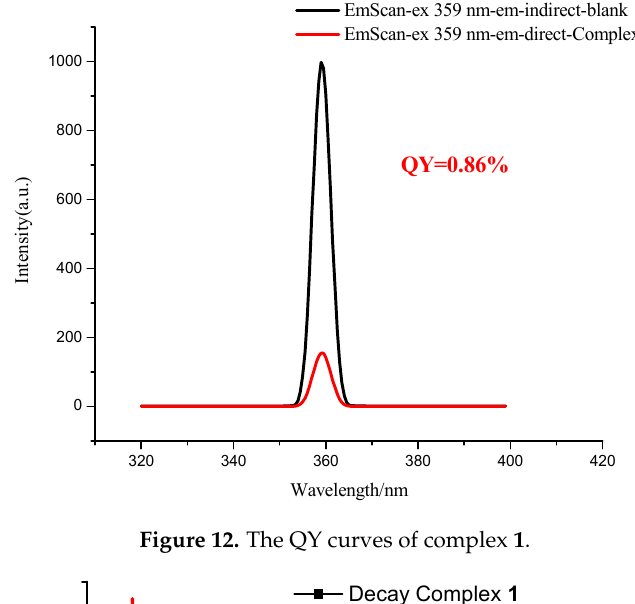
Figure 12. The QY curves of complex 1 .